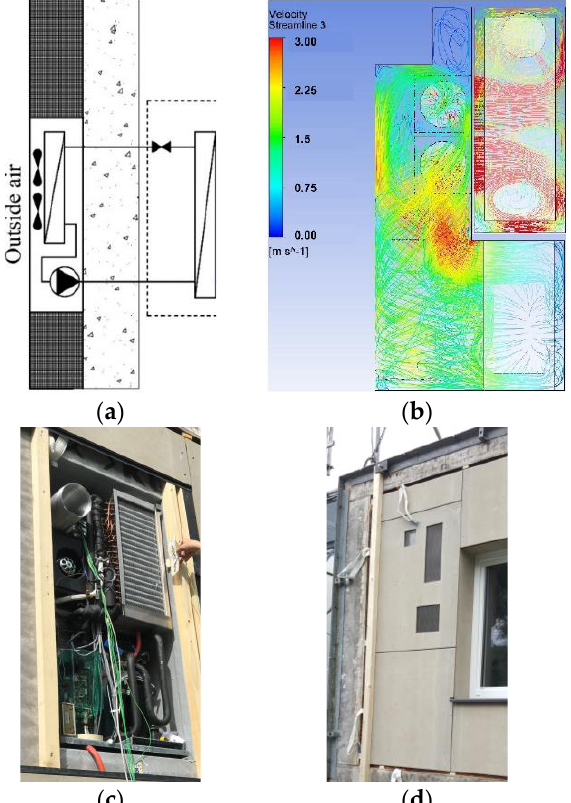
Figure 20. Façade integrated outdoor unit of an exhaust to supply air heat pump with external compressor ( a ), ( b ) airflow streamlines (for velocity) inside the mock-up from CFD simulations with two radial fans, picture of the functional model of the outdoor unit (( c ) with open casing and ( d ) with closed casing) resulting from the CFD analysis realised within the Austrian (FFG) research project Salüh! (see also Ref.